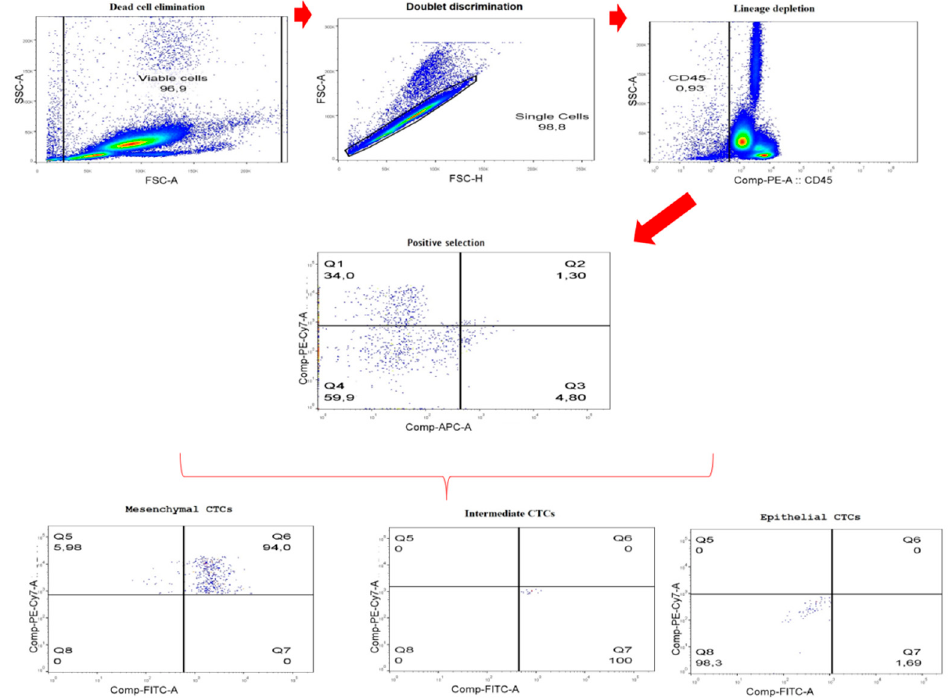
Figure 4. Representative scheme of the gating strategy using the CMP02 sample.